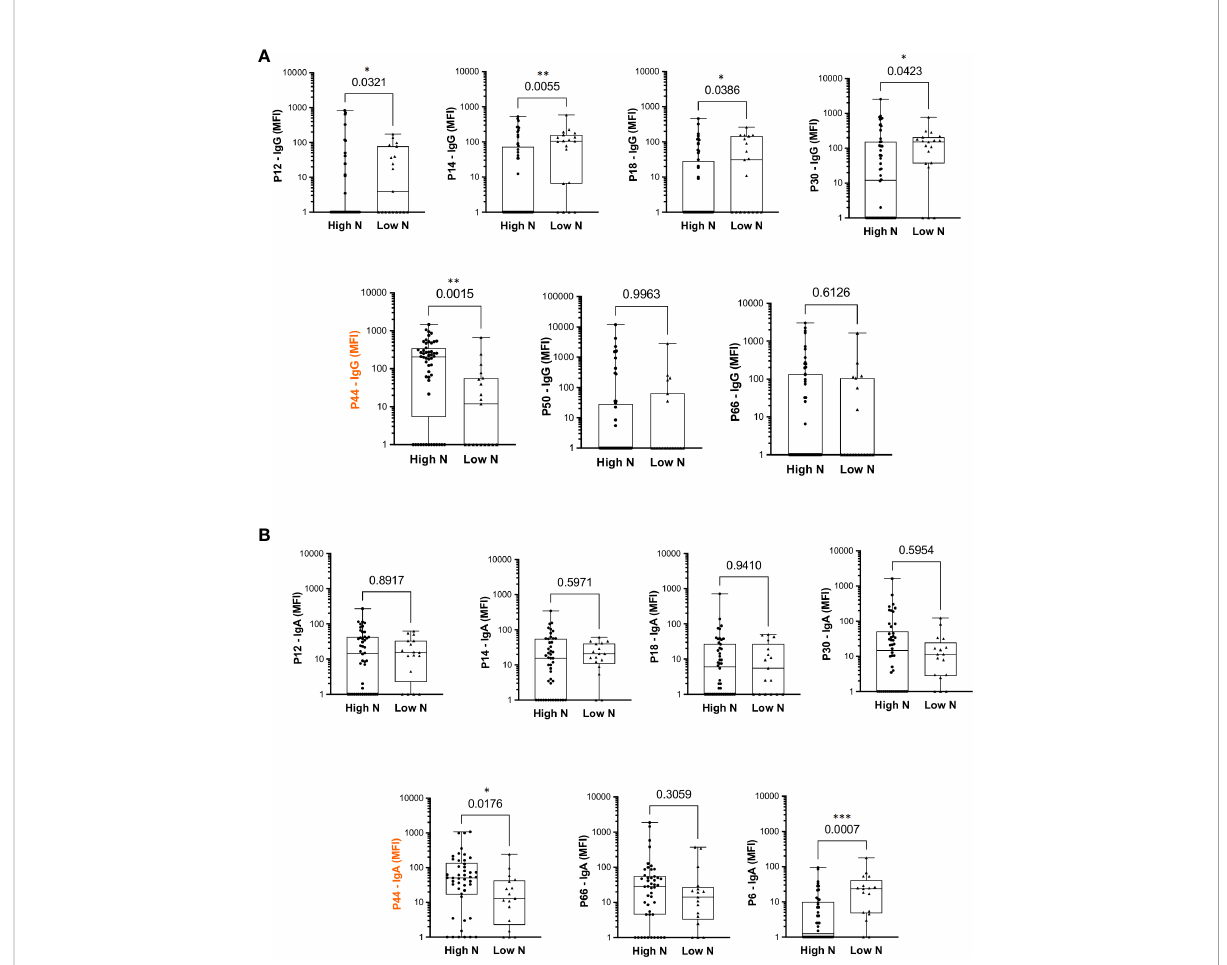
FIGURE 3 Differential intensity of reactivity to selected RBD peptides, comparing convalescents with high or low neutralizing capacity. (A) IgG pro fi le. (B) IgA pro fi le. High N: individuals with high neutralization capacity ( ≥ 1:160 virus neutralization titer); Low N: individuals with low neutralizing capacity (<1:160 virus neutralization titer); MFI: mean fl uorescence intensity; the median is shown as a solid line, the box indicates the 25th and 75th percentiles, whiskers range from the highest to the lowest value (all data points shown). Mann Whitney *p<0.05; **p<0.001;